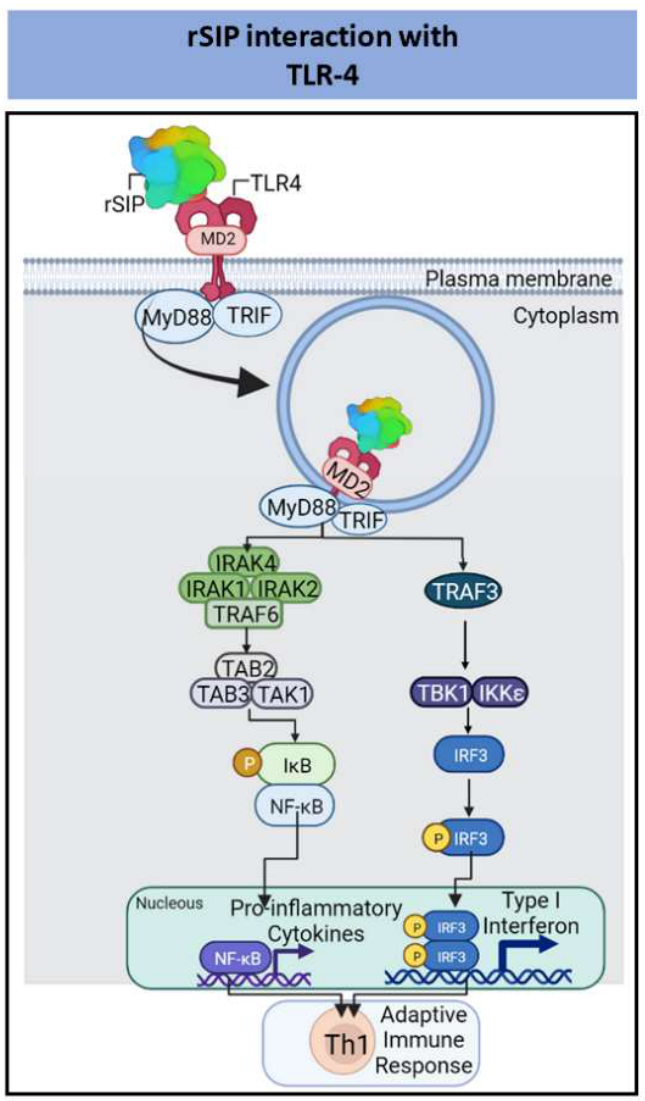
Figure 3. Molecular targets of rSIP and the adaptive immune response associated with TLR-4. The model shows that rSIP can interact at the cell surface of APC with TLR4 and induce a TLR4 pro-inflammatory response through the recruitment of adaptors MyD88- and TRIF-downstream signaling pathways, as described in Figure 1. As an adjuvant, rSIP stimulates innate immune cells to induce Th1-cell adaptive immune